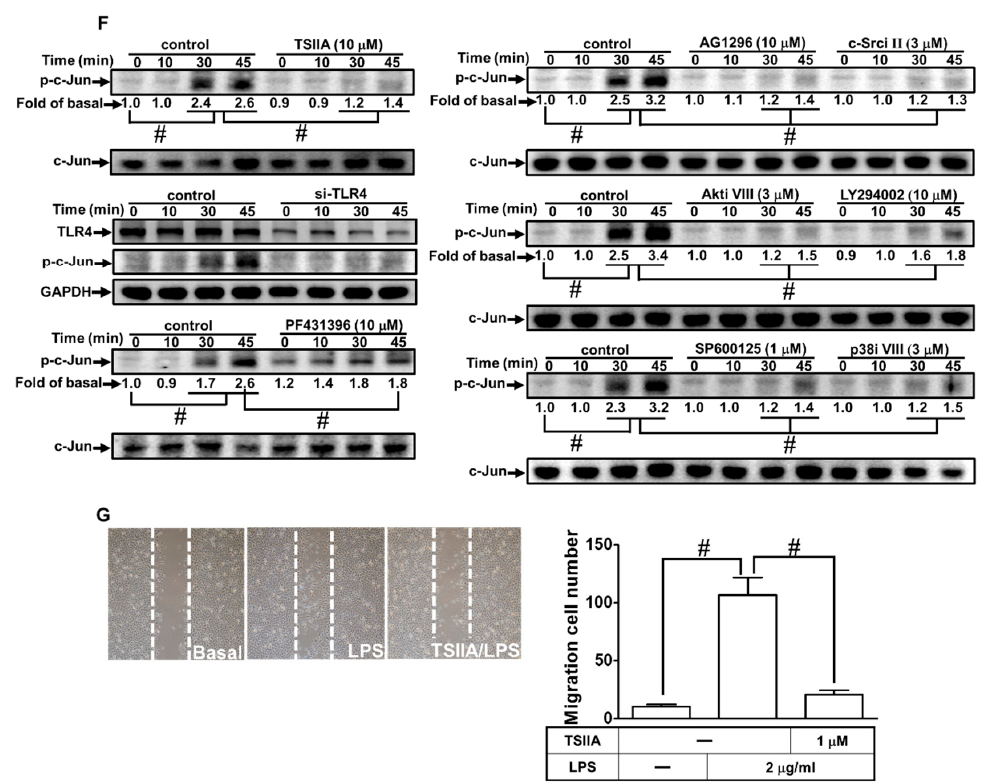
Figure 9. Activator protein 1 (AP-1) was necessary for LPS-induced MMP-9 expression and